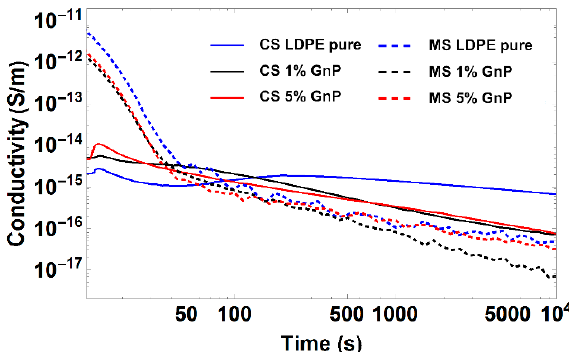
Figure 7. DC conductivity of produced nanocomposites, CS—solid line and MS—dashed line measured at a constant field 10 kV/mm.